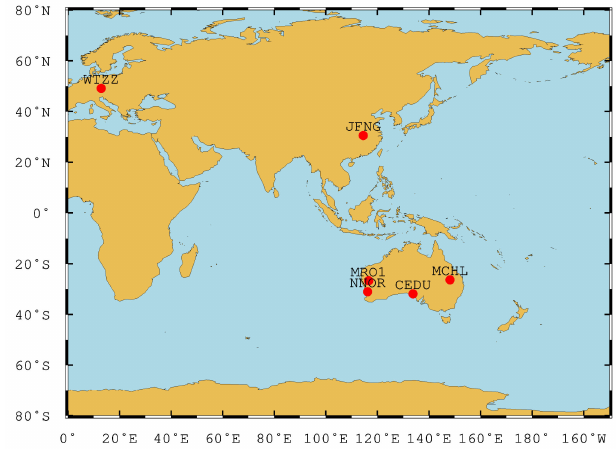
Figure 15. Distribution of the six selected